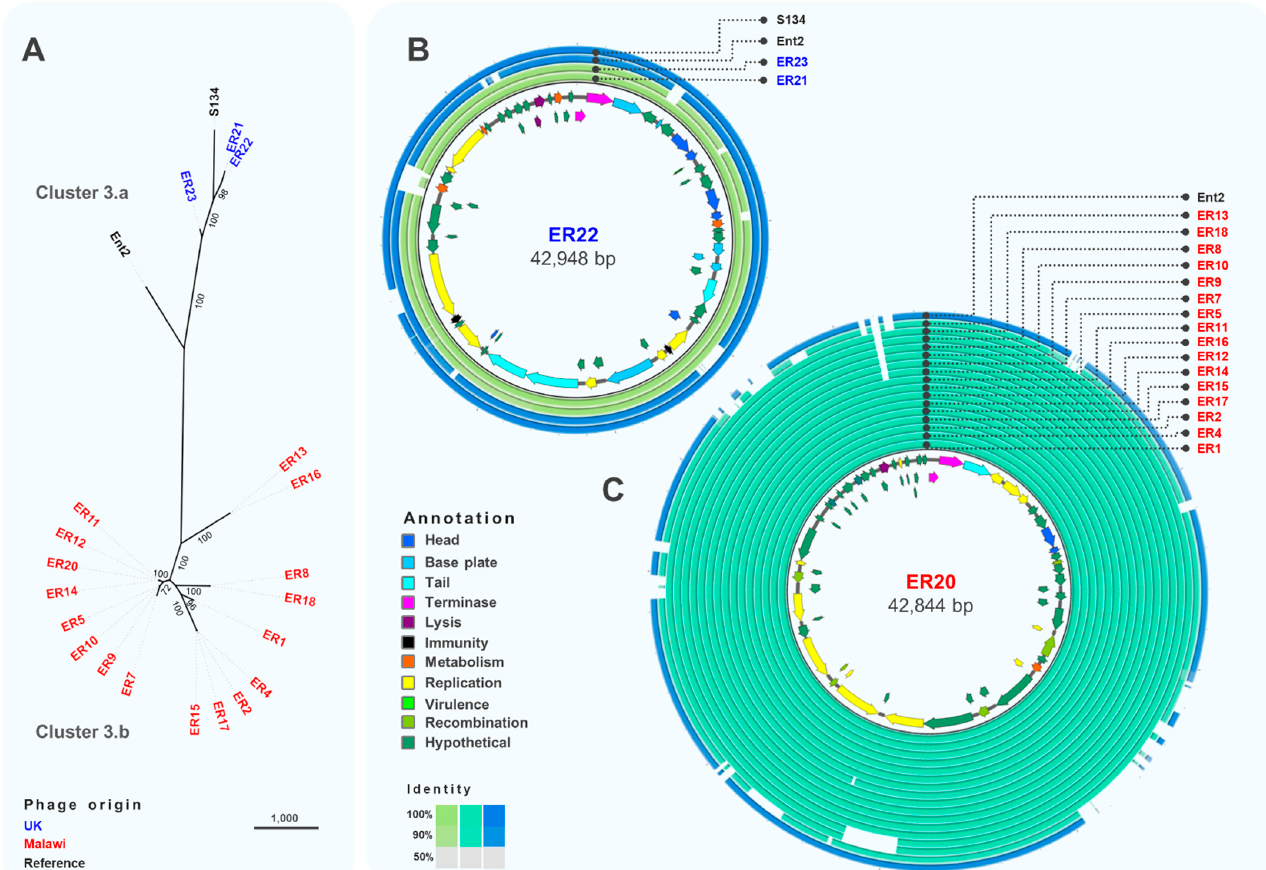
Figure 5. Comparative genomics of phages from Cluster 3. ( A ) Maximum-likelihood tree of phages in Cluster 3, unrooted and visualised in iTOL with numbers on branches indicating bootstraps. Scale bar represents number of SNPs. Phage names in blue were isolated from the UK and red from Malawi. Names in black font indicate reference phages. ( B ) Whole-genome comparison of phages in Cluster 3.a. The local similarity of each phage genome at the nucleotide level was calculated based on BLASTn high scoring pairs and plotted against a circular map of ER22, represented as the inner circle. Blue circles represent reference genomes. Genome annotation is shown as arrows in the inner circle, colour-coded based on gene categories. Full annotation can be found in Table S4. ( C ) Whole-genome comparison of phages in Cluster 3.b. The local similarity of each genome was calculated based on BLASTn high scoring pairs and plotted against a circular map of ER20 represented as the inner circle. Blue circles represent reference genomes. Genome annotation is shown as arrows in the inner circle, colour-coded based on gene categories. Full annotation can be found in Table S5.